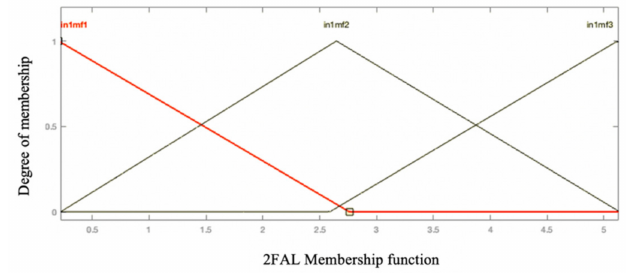
Figure 6. Proposed ANFIS 2FAL Membership function.